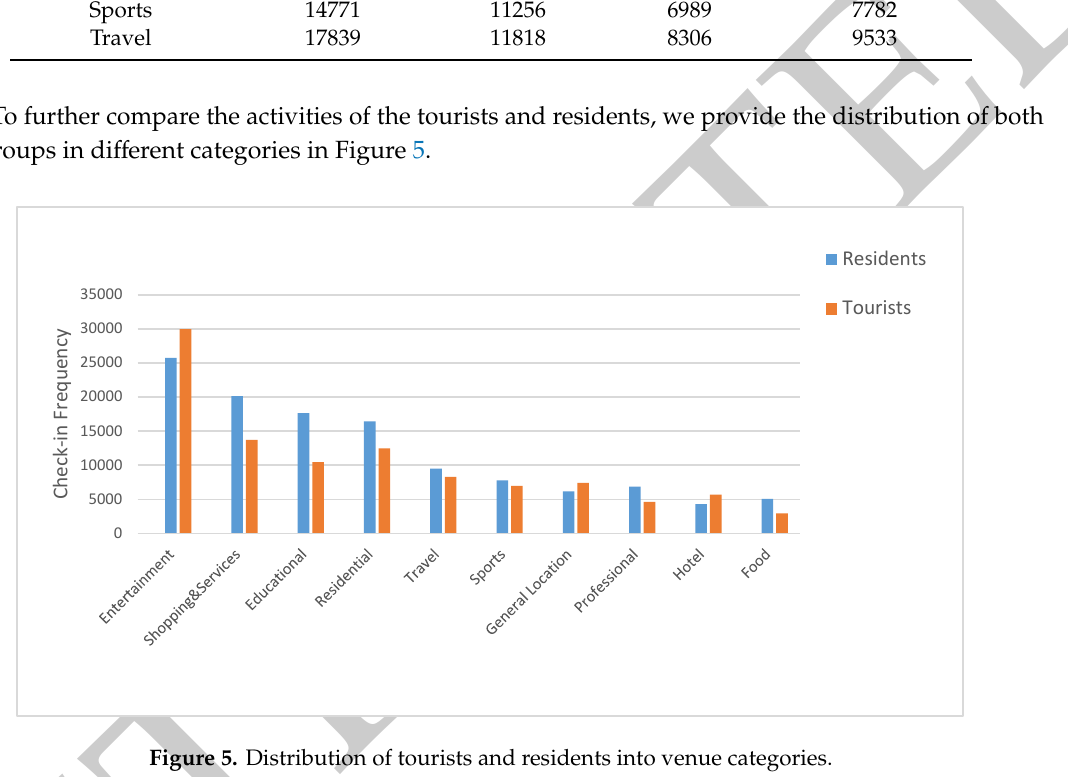
Figure 5. Distribution of tourists and residents into venue categories.